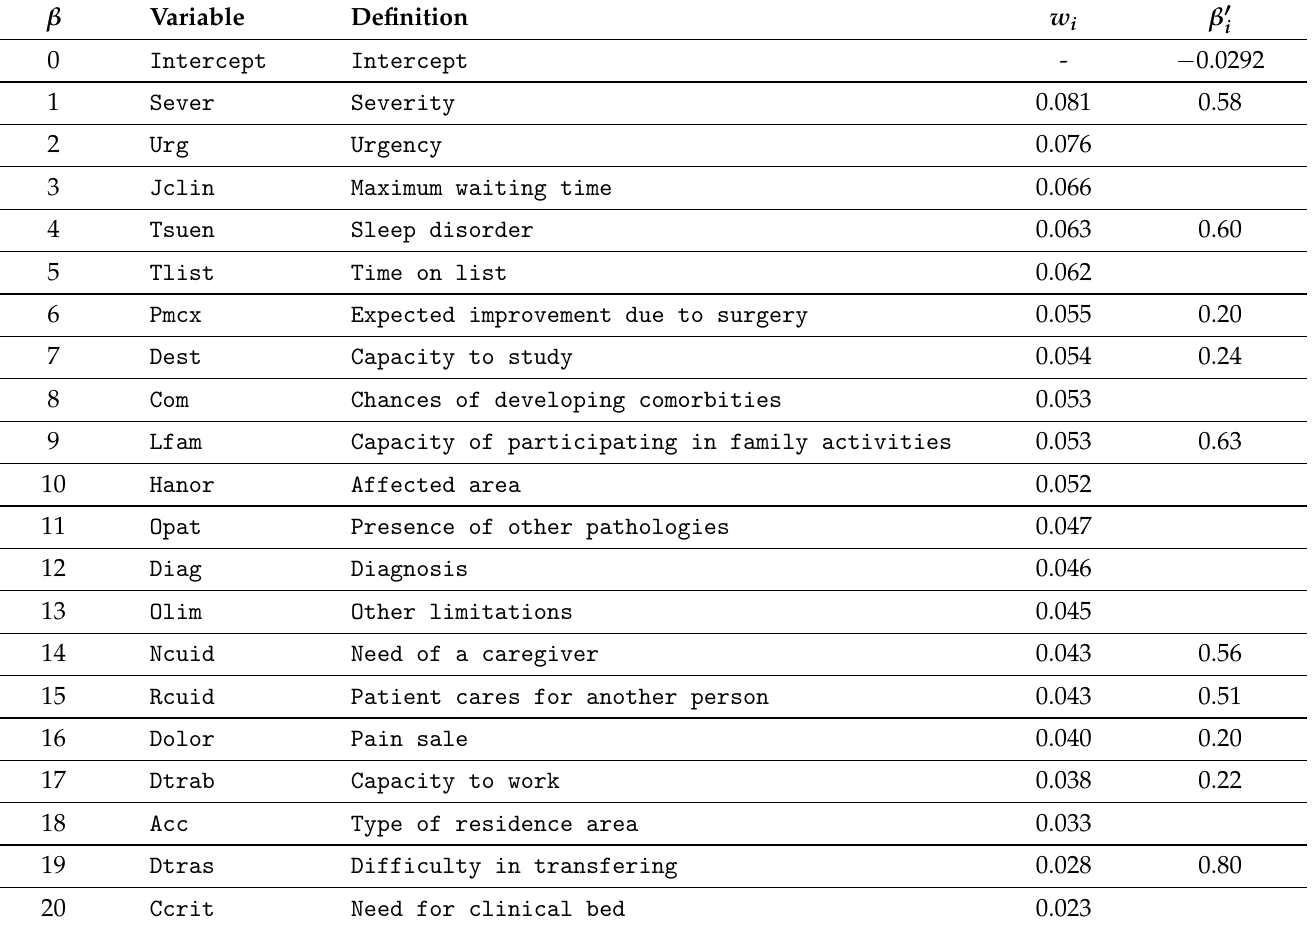
Table 1. The variables used by the physicians of the ENT unit to prioritize patients on the surgical waiting list with their weights of relative importance, w i , (see, Silva-Aravena et al. [14] and the β (cid:48) the SB strategy proposed in this work (see ( 3